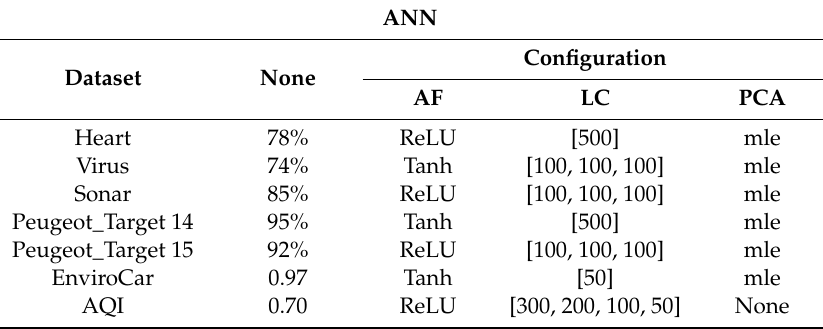
Table 14. Performance and configuration of ANN with no scaling.